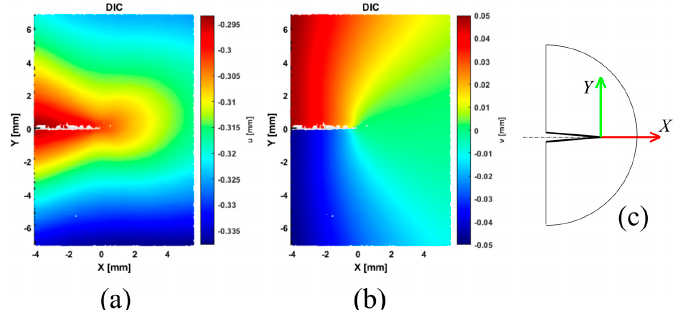
Figure 4. ( a ) x-displacement ( u ) and ( b ) y-displacement ( v ) of the AM-0-42-42-1 specimen obtained by the DIC (digital image correlation). ( c ) Position and orientation of the frame of reference used. For Mode I, u and v are computed as functions of the polar coordinates ( r , θ ), according to the infinite series of Equations (3) and (4).